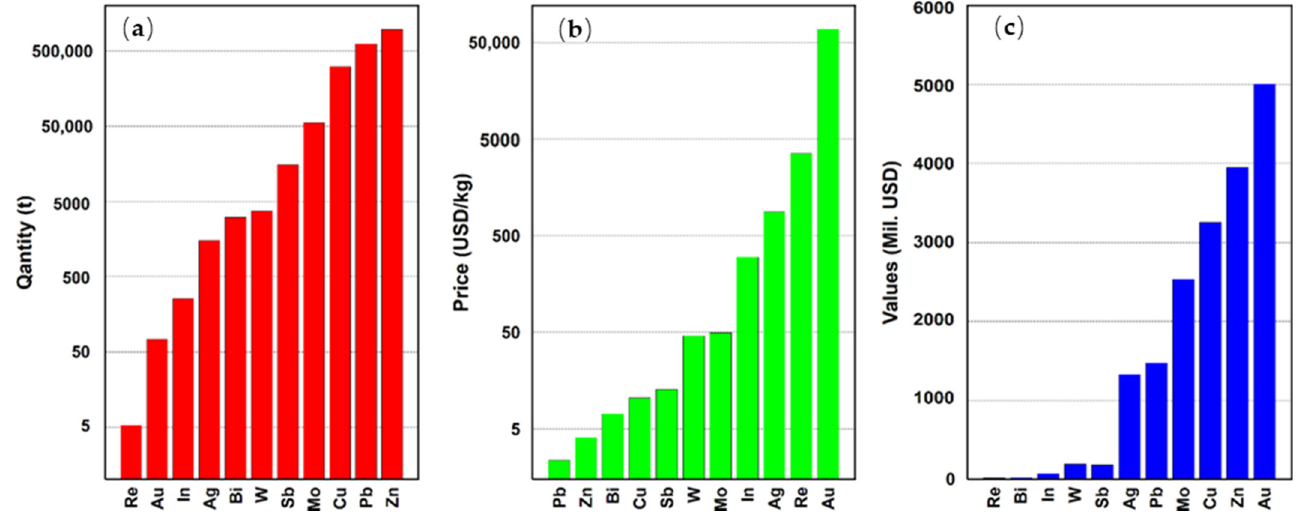
Figure 7. Quantity ( a ), prices ( b ), and values ( c ) of valuable elements.